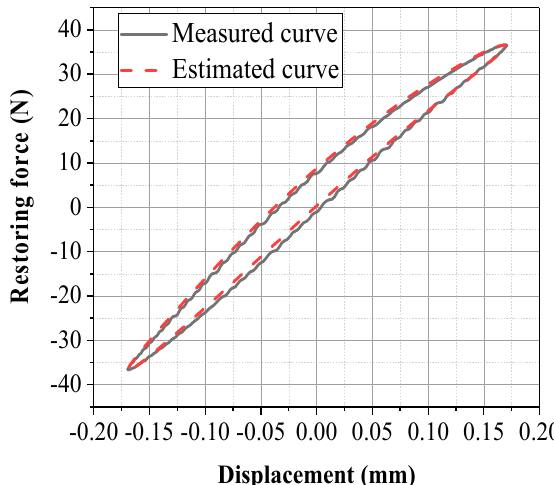
Figure 12. Comparison between the measured curve and estimated curve (vibration amplitude = 0.172 mm, frequency = 5 Hz).